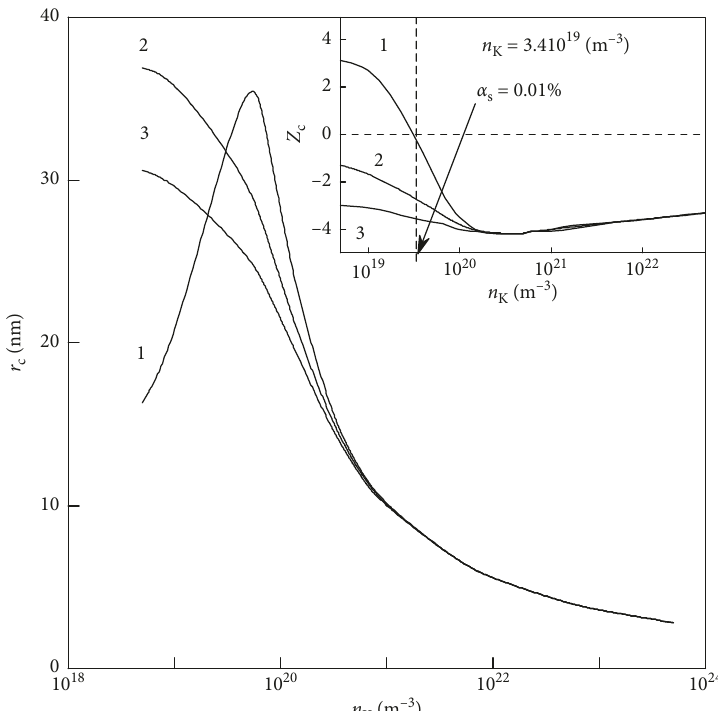
Figure 3: Dependence of Al 2 O 3 particle radius on the concentration of potassium atoms for different concentrations of aluminum atoms ( T g � 3200K). 1, n Al � 10 18 m − 3 ; 2, n Al � 5 · 10 21 m − 3 ; 3, n Al � 10 22 m − 3